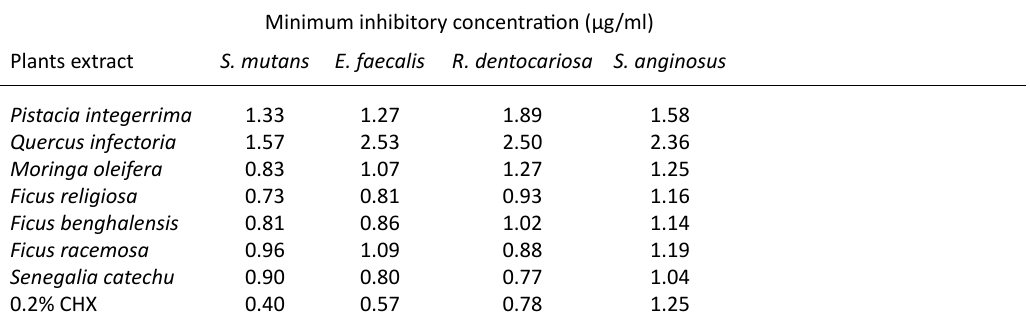
Table 3. Minimum inhibitory concentration (MIC values of potential plant extracts against isolated bacteria Minimum inhibitory concentration (µg/ml) Plants